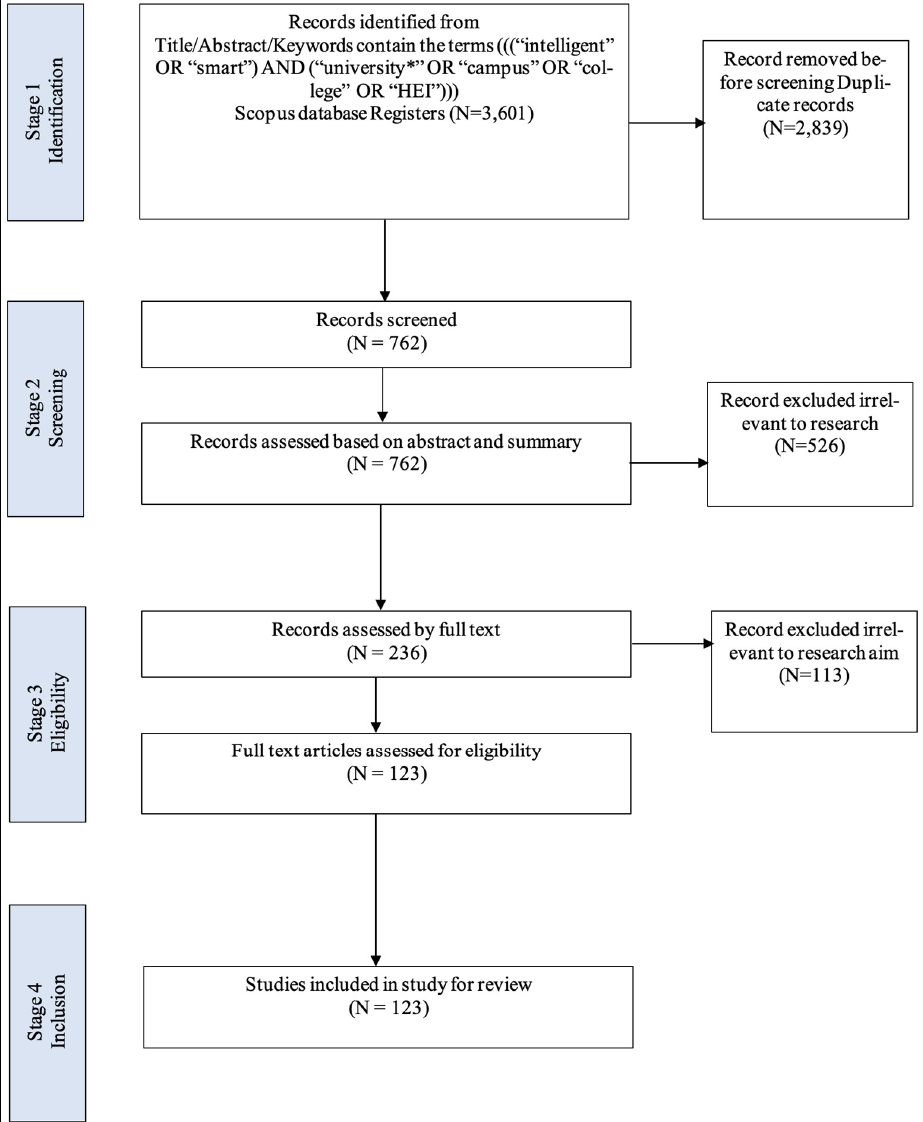
Figure 1. PRISMA review flow chart.